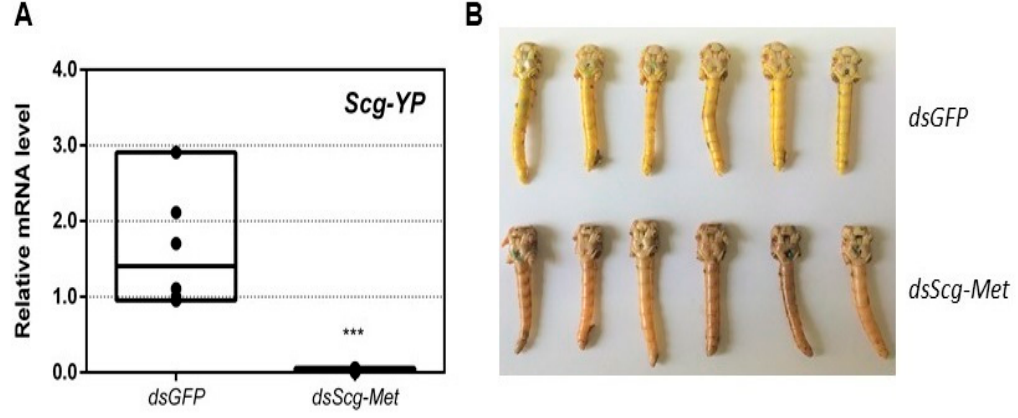
Figure 3. ( A ) Relative mRNA levels of Scg-YP measured in the epidermis of dsGFP and dsScg-Met injected adult male desert locusts 34 days after the adult molt. Scg-YP transcript levels were significantly lower after Met silencing. Transcript levels in the epidermis were normalized against two reference genes, Scg-Act and Scg-Ef1a . Data points are represented in a column graph as a floating bar (min to max value) with a line indicating the median. For every condition six biological replicates, each consisting of the pooled epidermis samples from three individual locusts, were analyzed by q-RT-PCR. Significant differences (Student’s T-test) are indicated with asterisks (*** p < 0.001) (the statistical p-value obtained for Scg-YP was 0.0002). ( B ) Pictures of the abdomen of both dsGFP treated (top, yellow) and dsScg-Met treated (bottom, beige/brown) male locusts 34 days after the adult molt. In clear contrast with the dsScg-Met injected locusts, all control animals displayed normal copulation behavior and had the bright yellow cuticular coloration that is typical for sexually mature gregarious desert locust males. (Abbreviations: ds = double stranded, Scg = Schistocerca gregaria , GFP = Green Fluorescent Protein, Met = Methoprene-tolerant, YP = yellow protein, Act = actin, Ef1a = elongation factor 1-alpha).